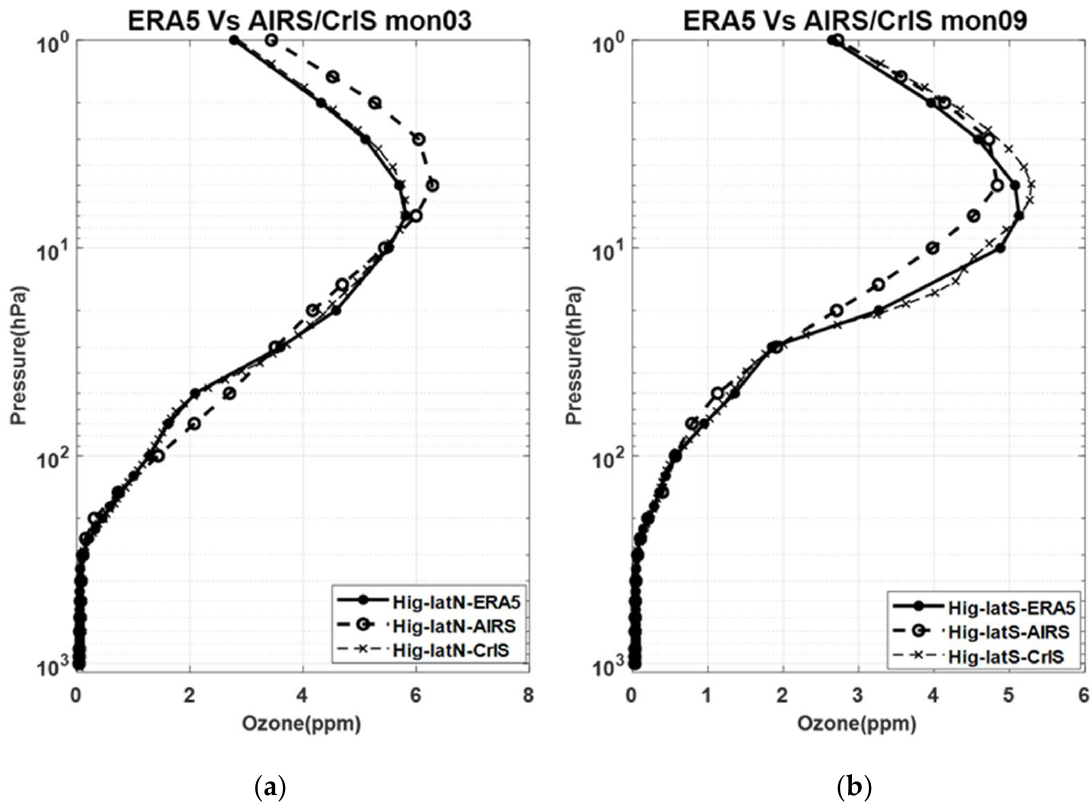
Figure 7. The monthly mean ozone profiles obtained from CrIS, AIRS, and ERA5 datasets at high latitudes. ( a ) northern hemisphere in March 2020; ( b ) southern hemisphere in September.